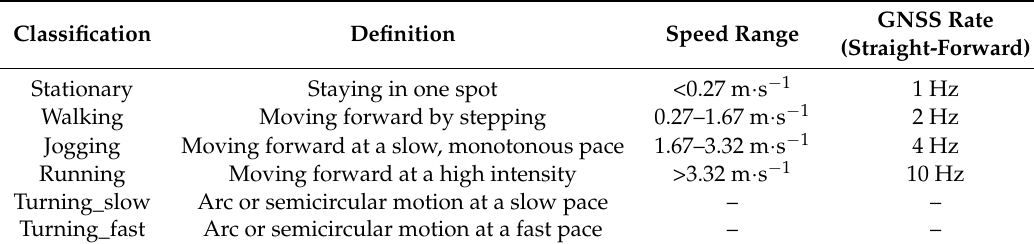
Table 2. Football activity types in this work.